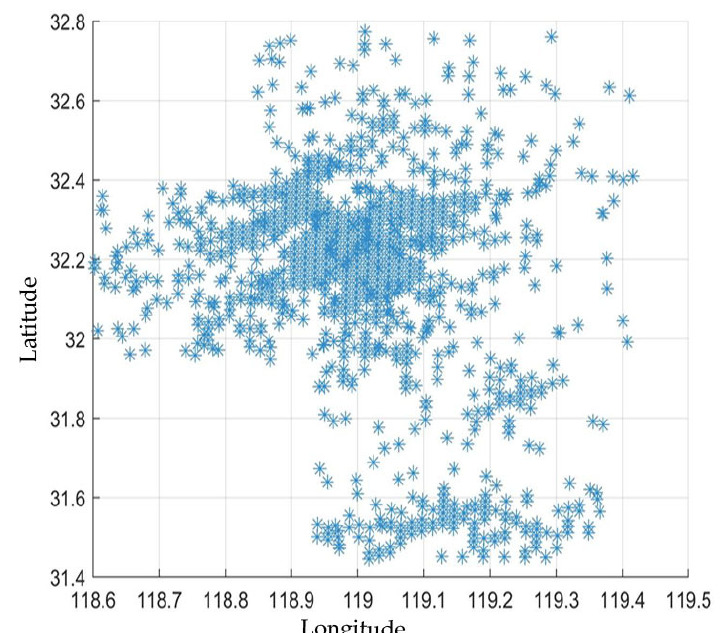
Figure 10. Random demand (fire outbreak) points.